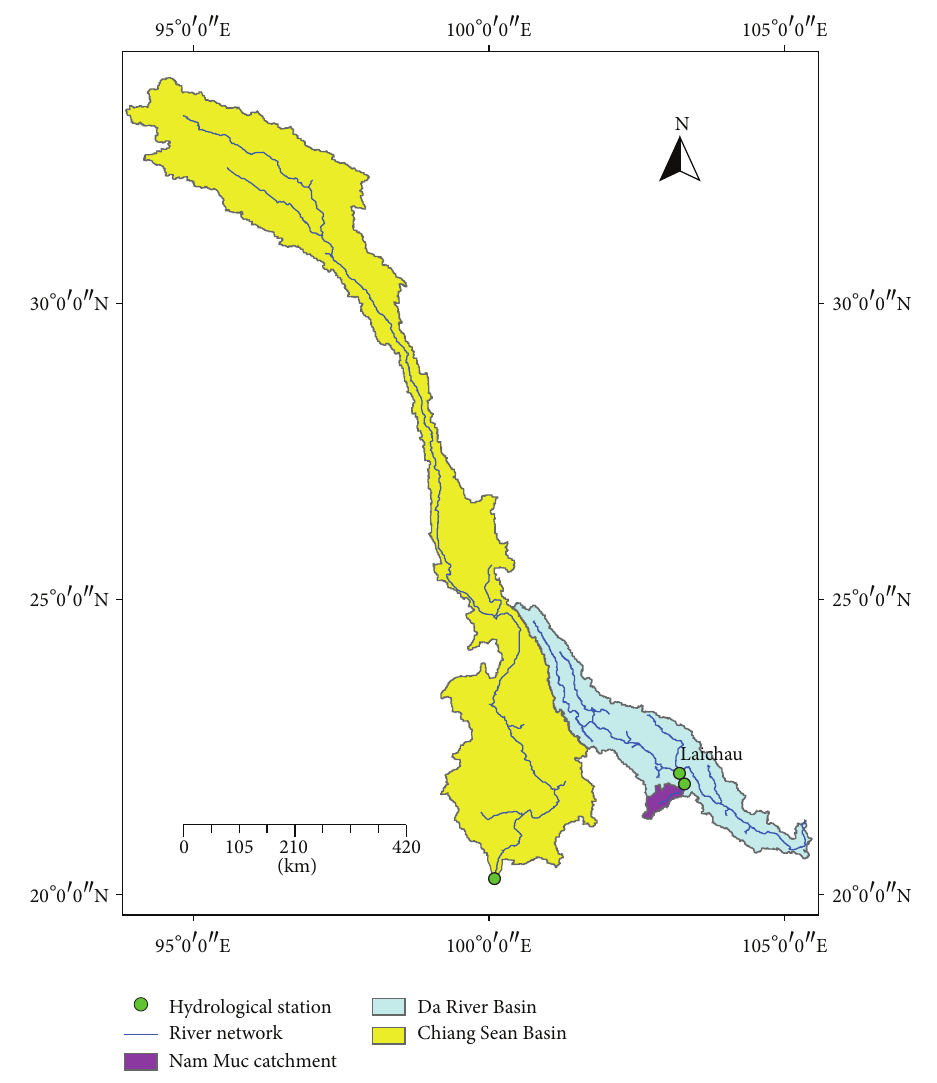
Figure 2: Location of three target basins.